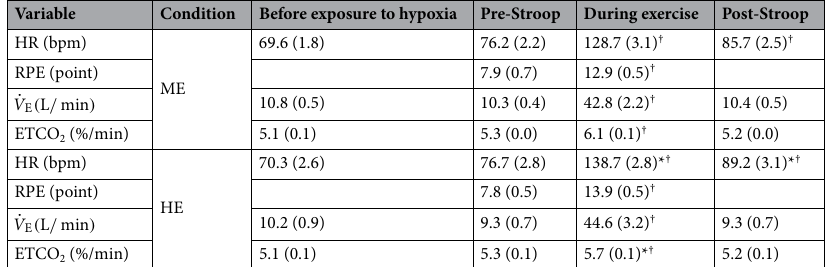
Table 1. Physiological parameters. The value of each indicator is averaged over the 3 min before exposure to hypoxia, during the Stroop task (Pre and Post, 6.5 min each), and during exercise (10 min). HE, hypoxic exercise; ME, milder hypoxic exercise; HR, heart rate; RPE, ratings of perceived exertion; ETCO 2 , end-tidal carbon dioxide concentration; bpm, beats per minute. Values are presented as mean (standard error). * P < 0.05 versus (vs.) ME condition, † P < 0.05 vs.